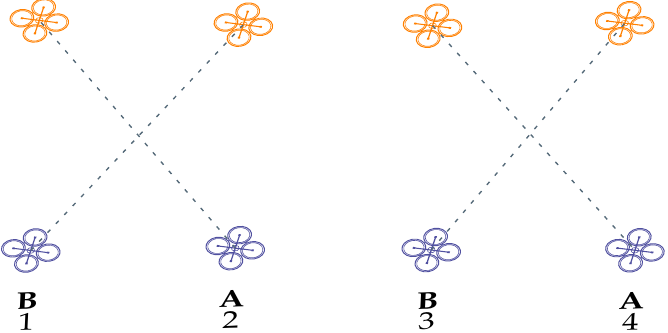
Figure 11. Example of take-off batch grouping (A, B) using our